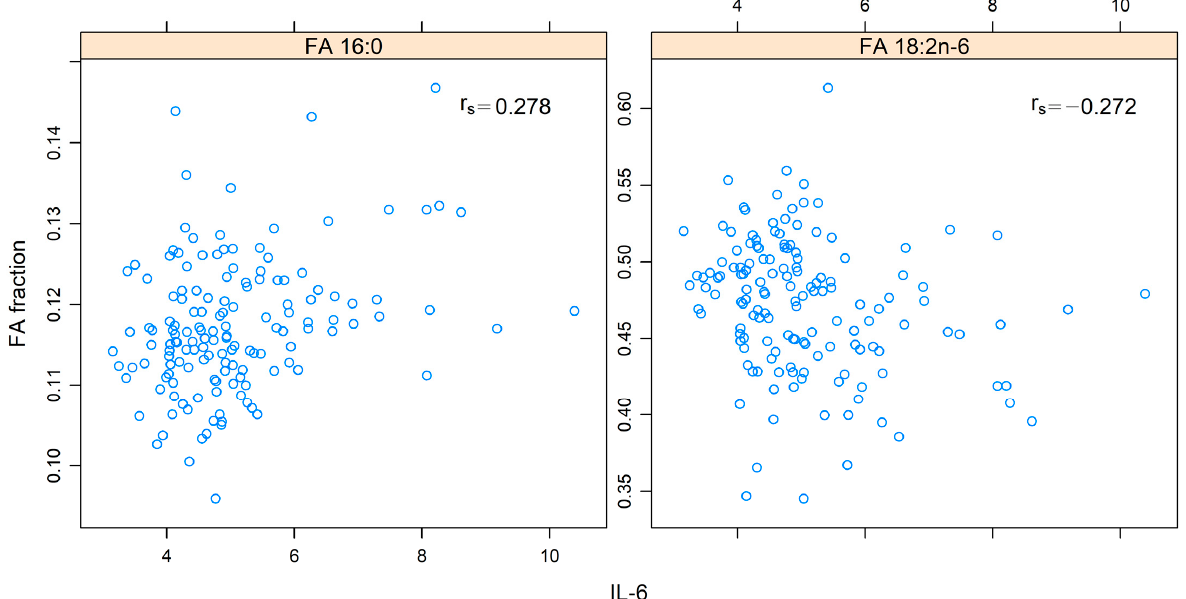
Figure 6. Spearman´s rank correlation (r s ) between fatty acids (FAs) 16:0 and 18:2n-6 and interleukin 6 (IL-6) at 1 year after the end of treatment in patients with head and neck cancer. The values for the FAs are presented in relation to the total amount of FAs. The values of IL-6 are presented in log-2 scale on the x -axis.